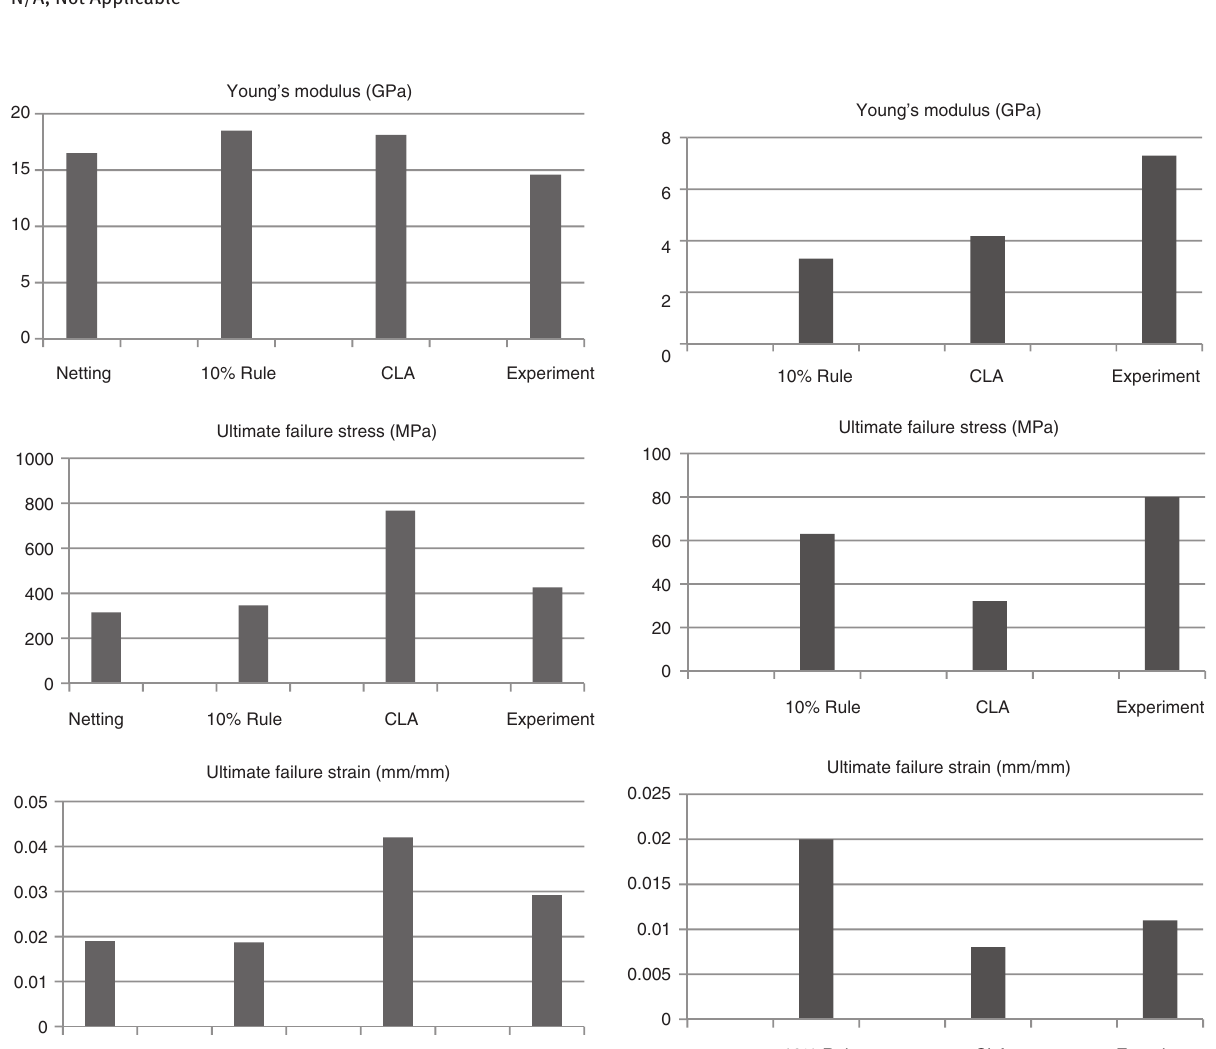
Table 2 Summary of [90